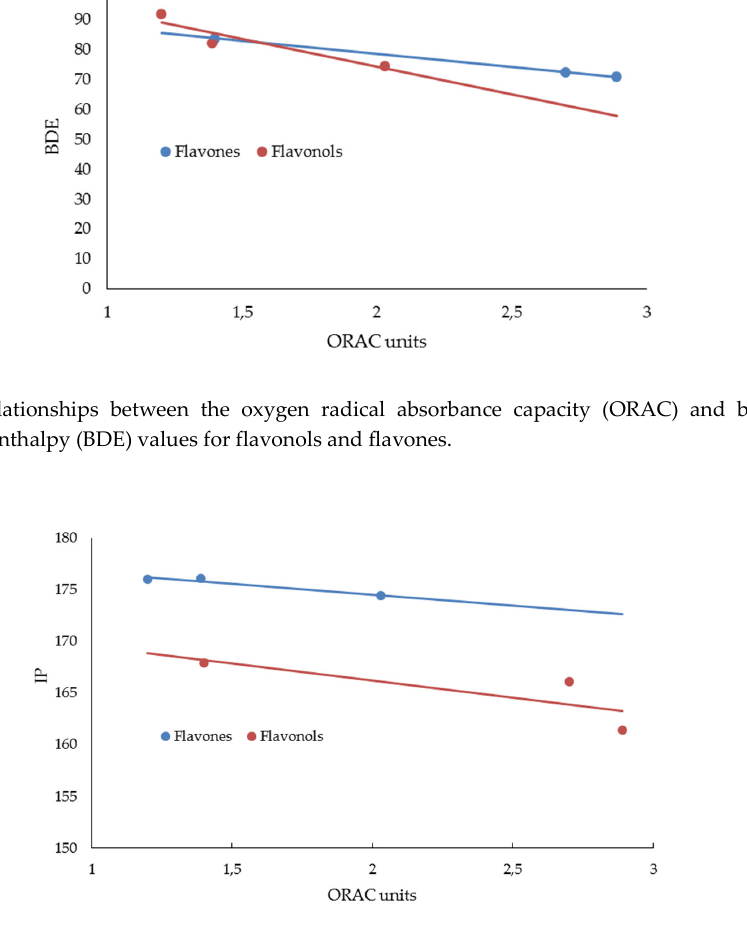
Figure 5. Relationships between the oxygen radical absorbance capacity (ORAC) and ionization potential (IP) values for flavonols and